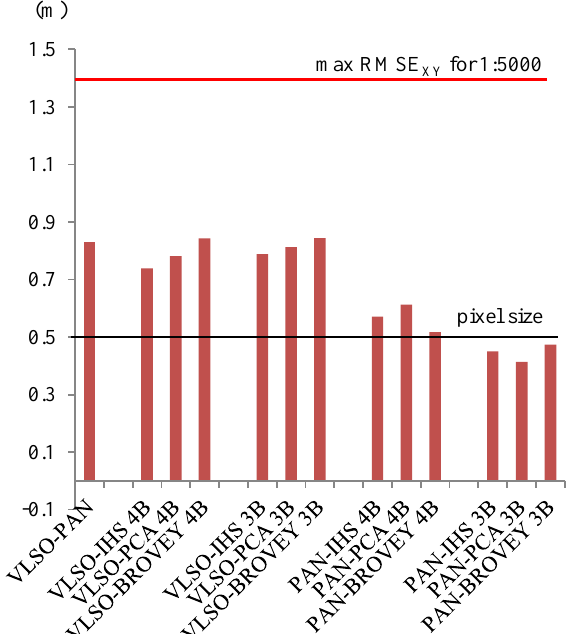
Figure 5: Graphic representation of the resulting residuals in meters